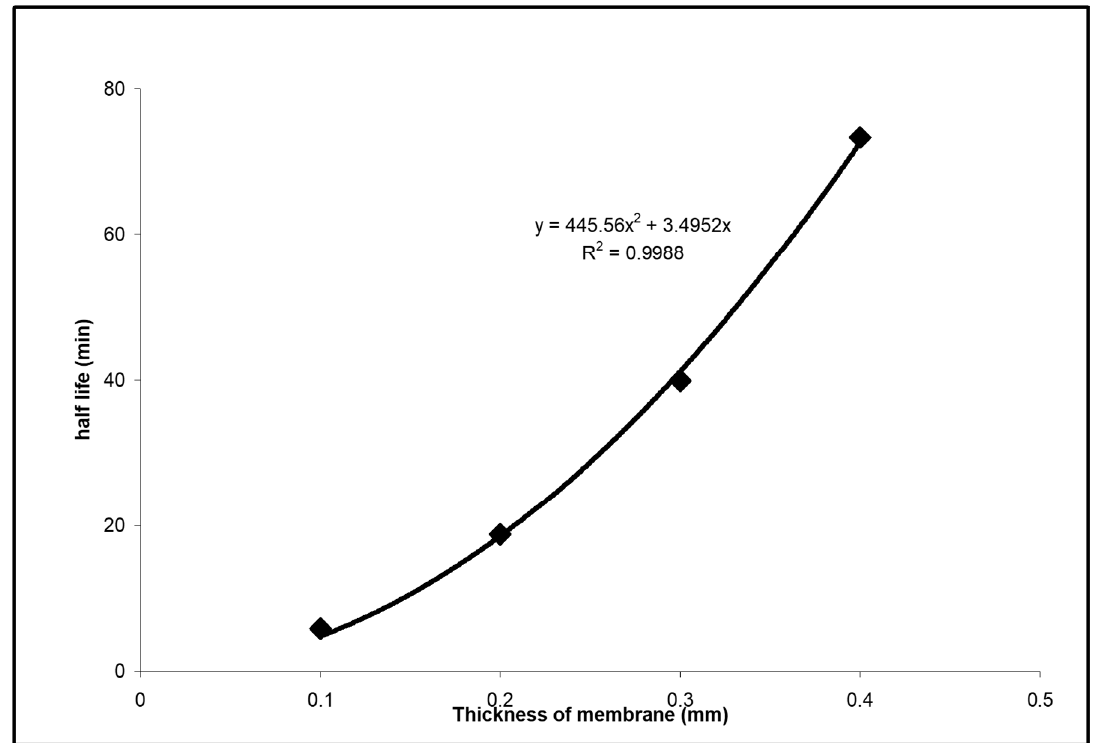
Figure 8. The half-life time of potential relaxation kinetics vs. the thickness of the membrane with 0.05-micrometer pores after the addition of 0.1 wt% Tergitol 15-S-7.